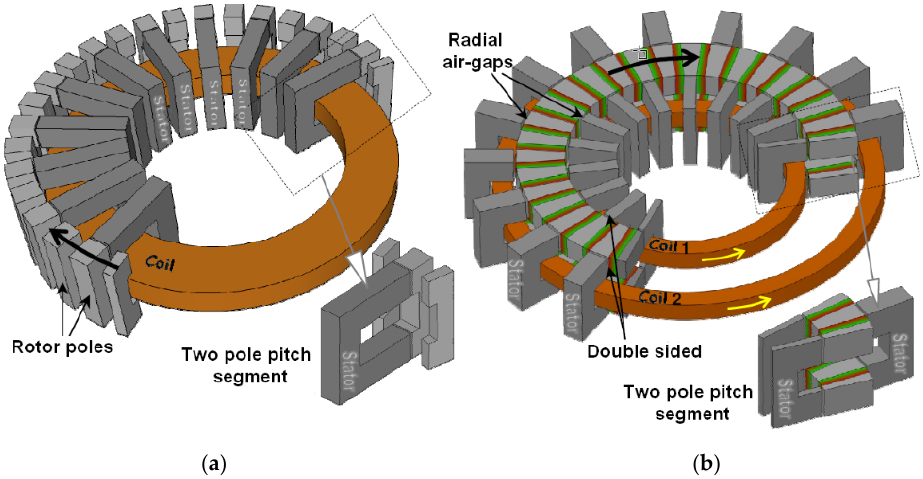
Figure 17. Two typical TFM constructions [178], reproduced with permission from the owner, Baserrah, S. ( a ) Reluctance TFM; ( b ) flux concentrating PM ‐ TFM. Baserrah, S. ( a ) Reluctance TFM; ( b ) flux concentrating